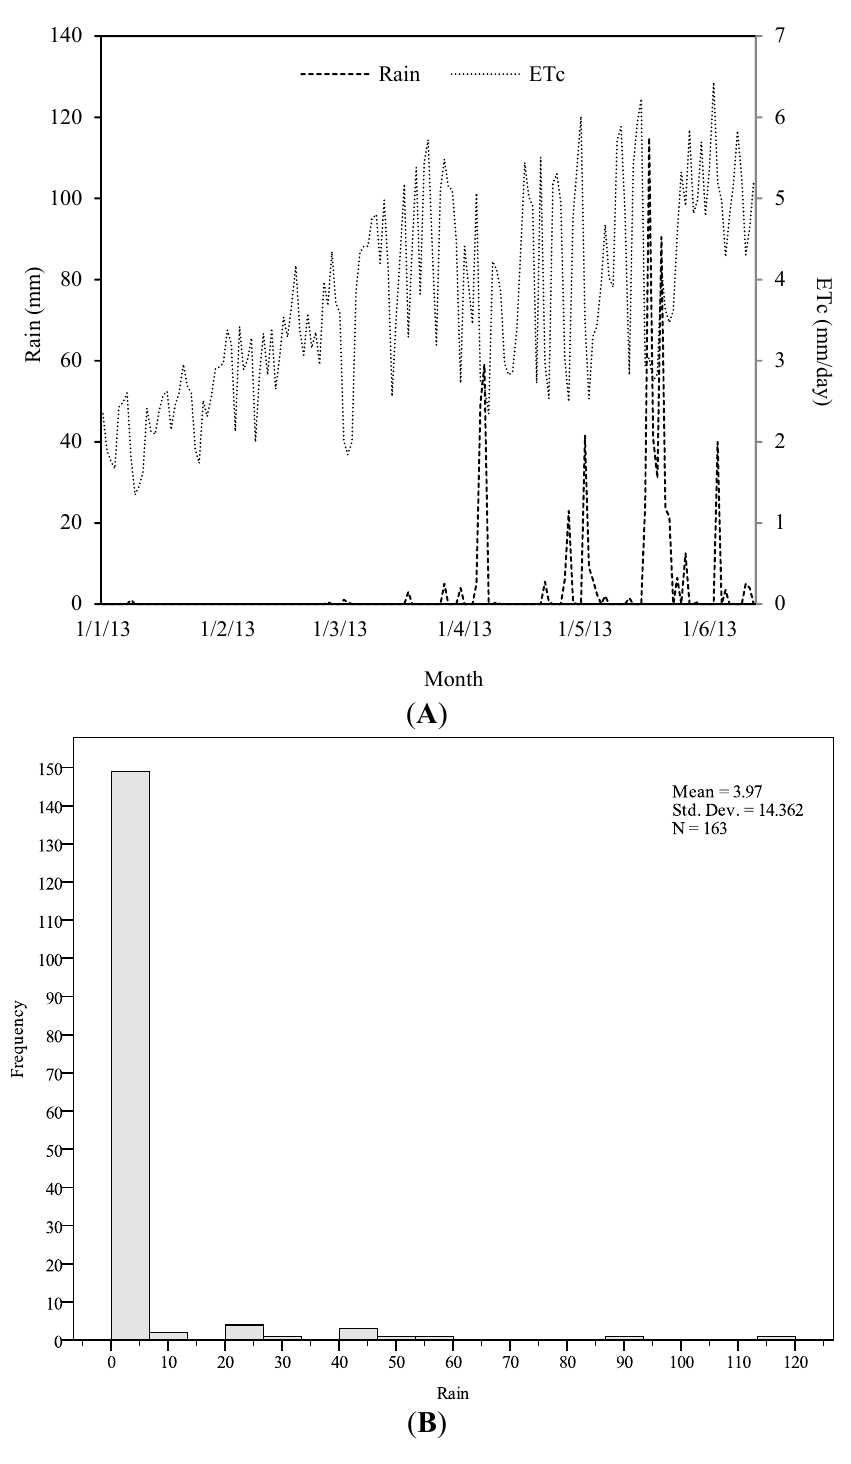
Figure 1. Sketch of daily rainfall and crop evapotranspiration ( A ) and rainfall distribution ( B ) during the production cycle (January to